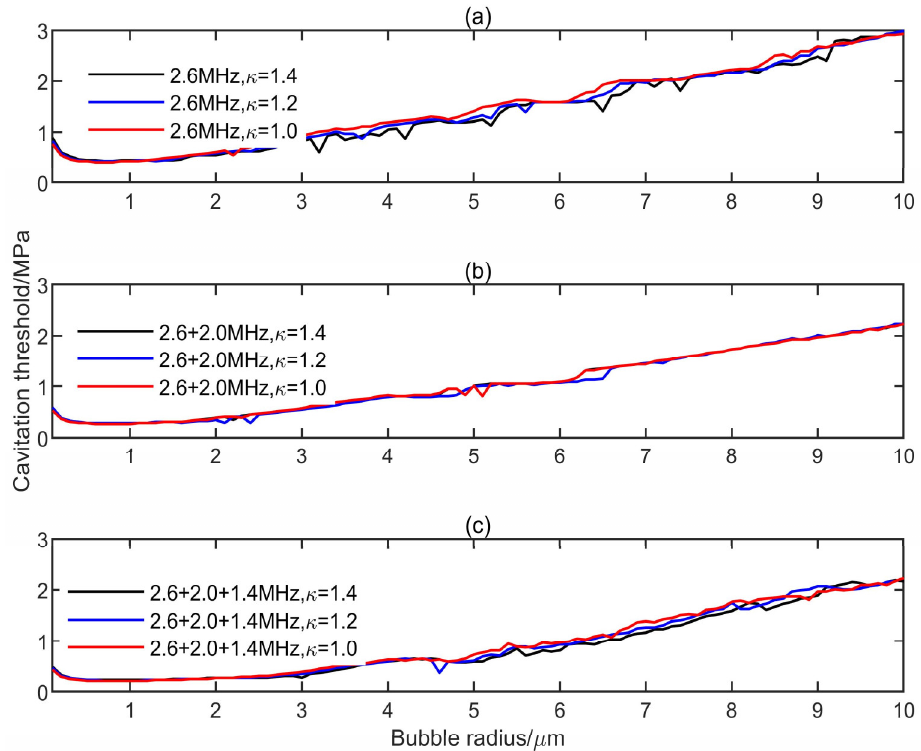
Figure 7. The influence of polytropic index on transient cavitation threshold under three different frequency combinations: ( a ) 2.6 MHz; ( b ) 2.6 + 2.0 MHz; ( c ) 2.6 + 2.0 + 1.4 MHz.